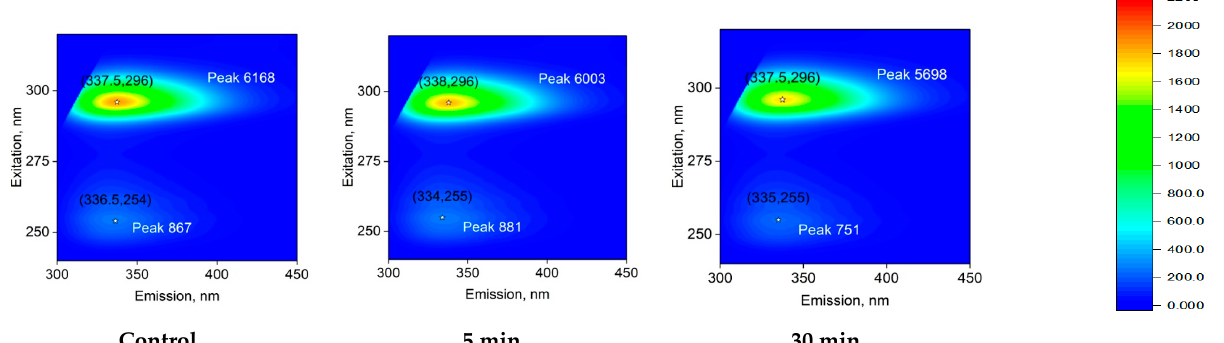
Figure 5. Effect of laser irradiation time on the fluorescence of BSA (5 mg/mL) protein solution (typical spectrum). 3D fluorescence maps are presented. The abscissa shows the range of emission wavelengths in nm ( λ em ). The ordinate shows the range of excitation wavelengths in nm ( λ ex ). The fluorescence intensity is expressed in relative units using a color scale, which is the same for all three spectra. The numbers in parentheses on the graphs indicate the local fluorescence maxima in the coordinates ( λ ex ; λ em ). Fluorescence intensity is indicated with the word Peak and a number.